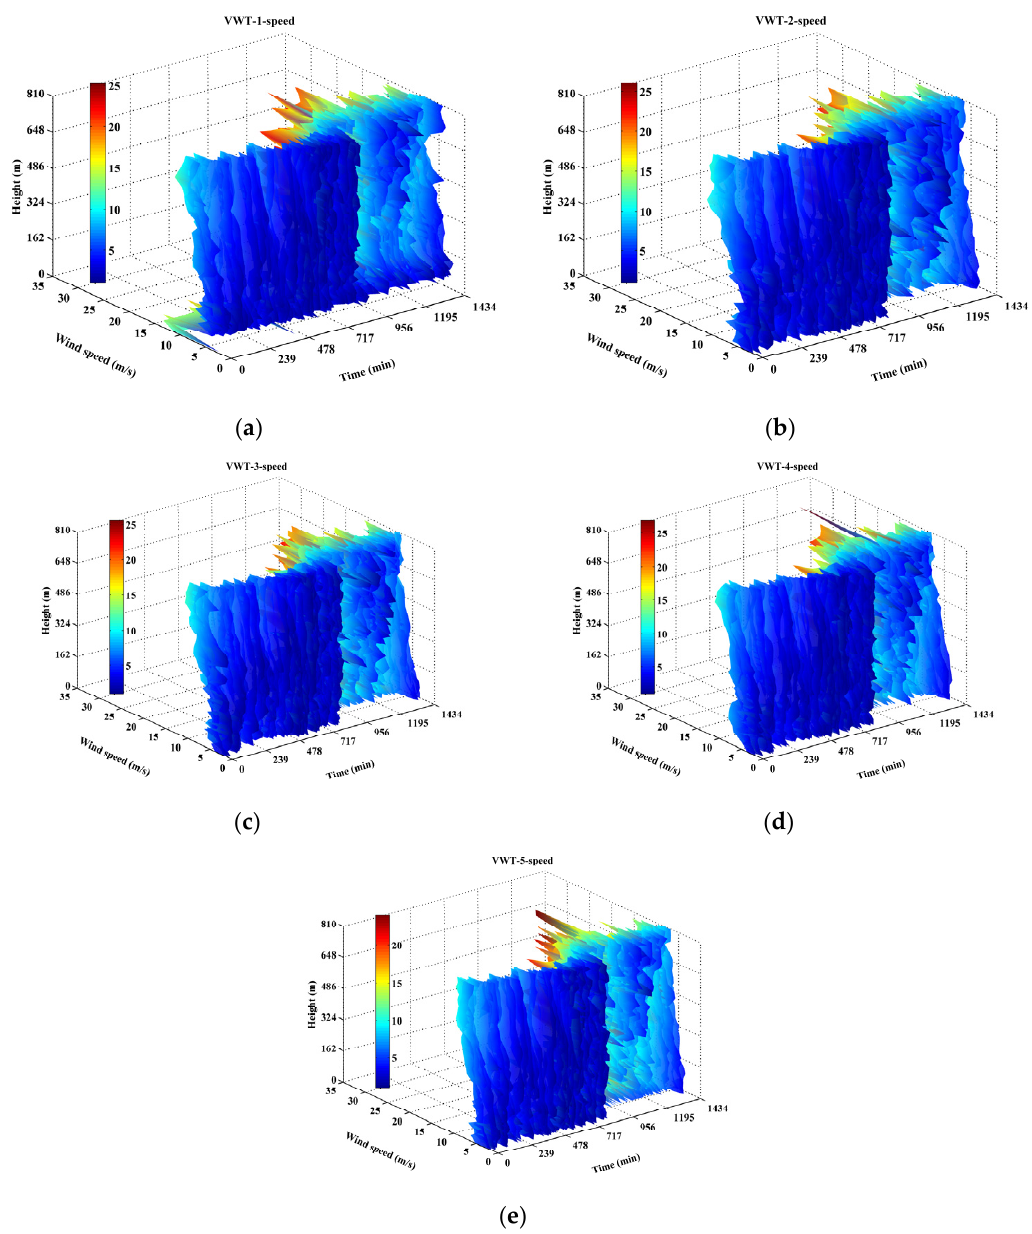
Figure 7. Spatio-temporal distribution of wind speed, ( a ) VWT-1; ( b ) VWT-2; ( c ) VWT-3; ( d ) VWT-4; ( e )